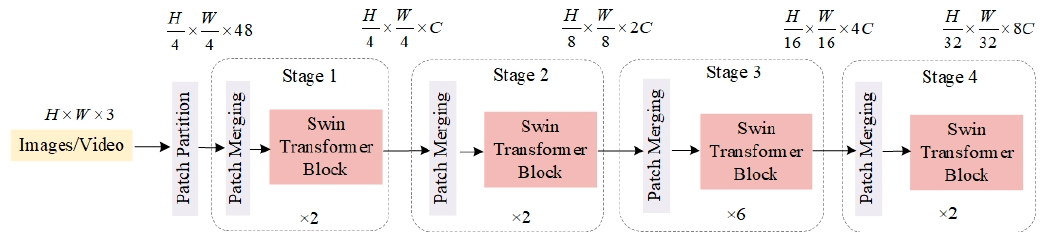
Figure 6. Swin Transformer network structure.